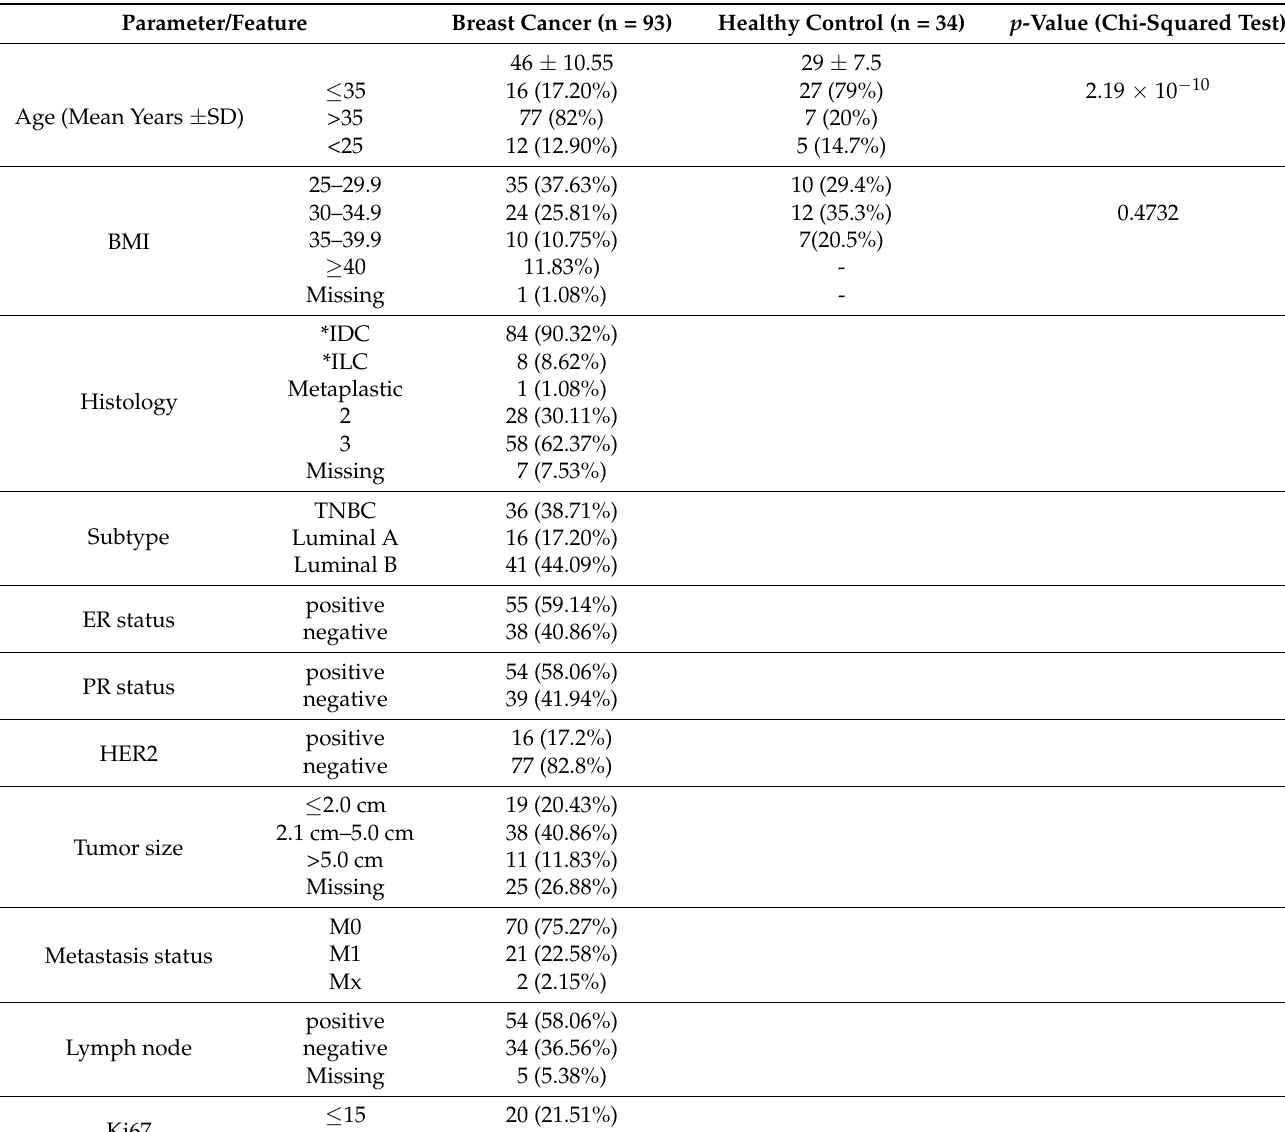
Table 1. Patient